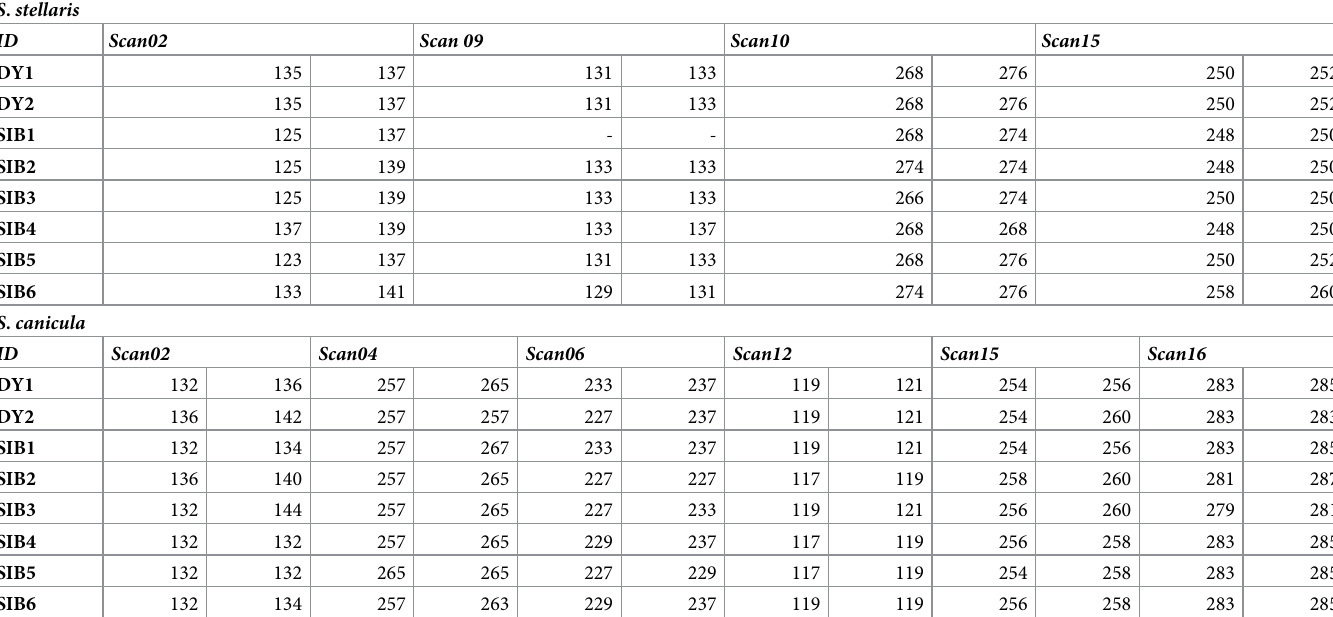
Table 1. Genotypic information gathered from each microsatellite locus for the twin individuals (DY1, DY2) and a further randomly selected 6 possible siblings (SIB1-SIB6) of S . stellaris and S . canicula to display the genotype variance. Microsatellites with a polymorphism information content (PIC) value equal to or higher than 0.500 were used to display genotypes.